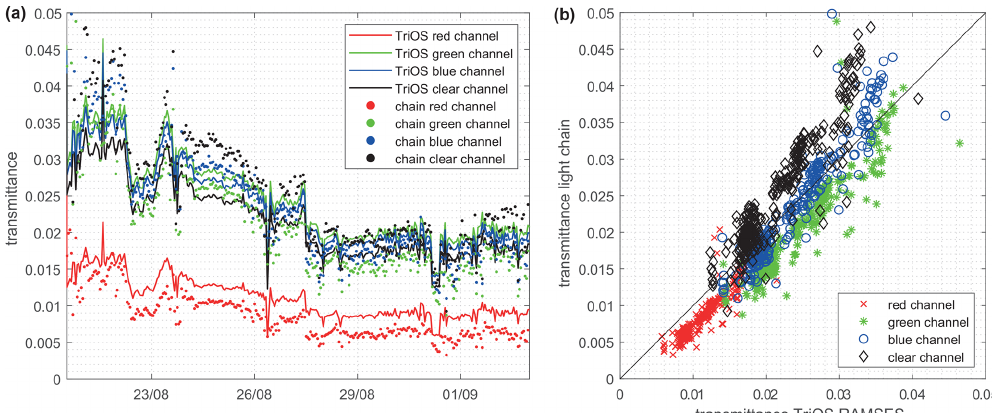
Figure 10. (a) Time series of sea ice transmittance in four spectral bands derived from the top- and bottommost chain sensors (dots), as well as from TriOS RAMSES radiometers above and below the ice (solid line). (b) Scatter plot of the dataset showing how close measurements from the light chain agree with high-quality hyperspectral